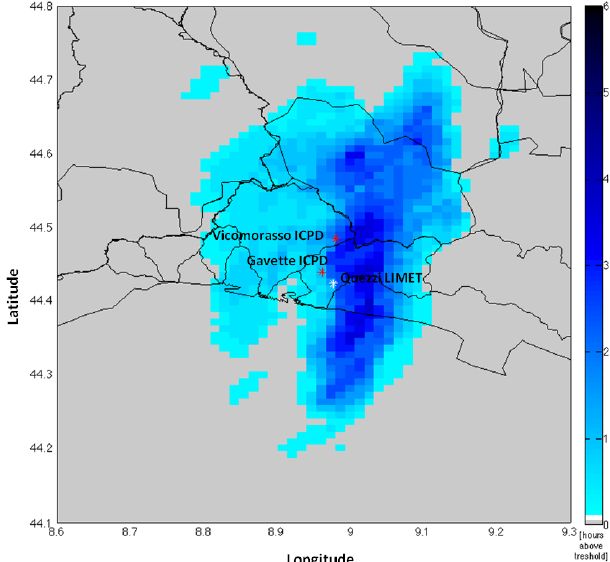
Fig. 7. Persistence of the 4 November structure indicated by the period of time (hours between 09:00UTC and 15:00UTC) where reflectivity was above a 40dBZ threshold. ICPD “Vicomorasso” e “Gavette” stations (red markers), and LIMET PWS “Quezzi” (white marker) are shown.